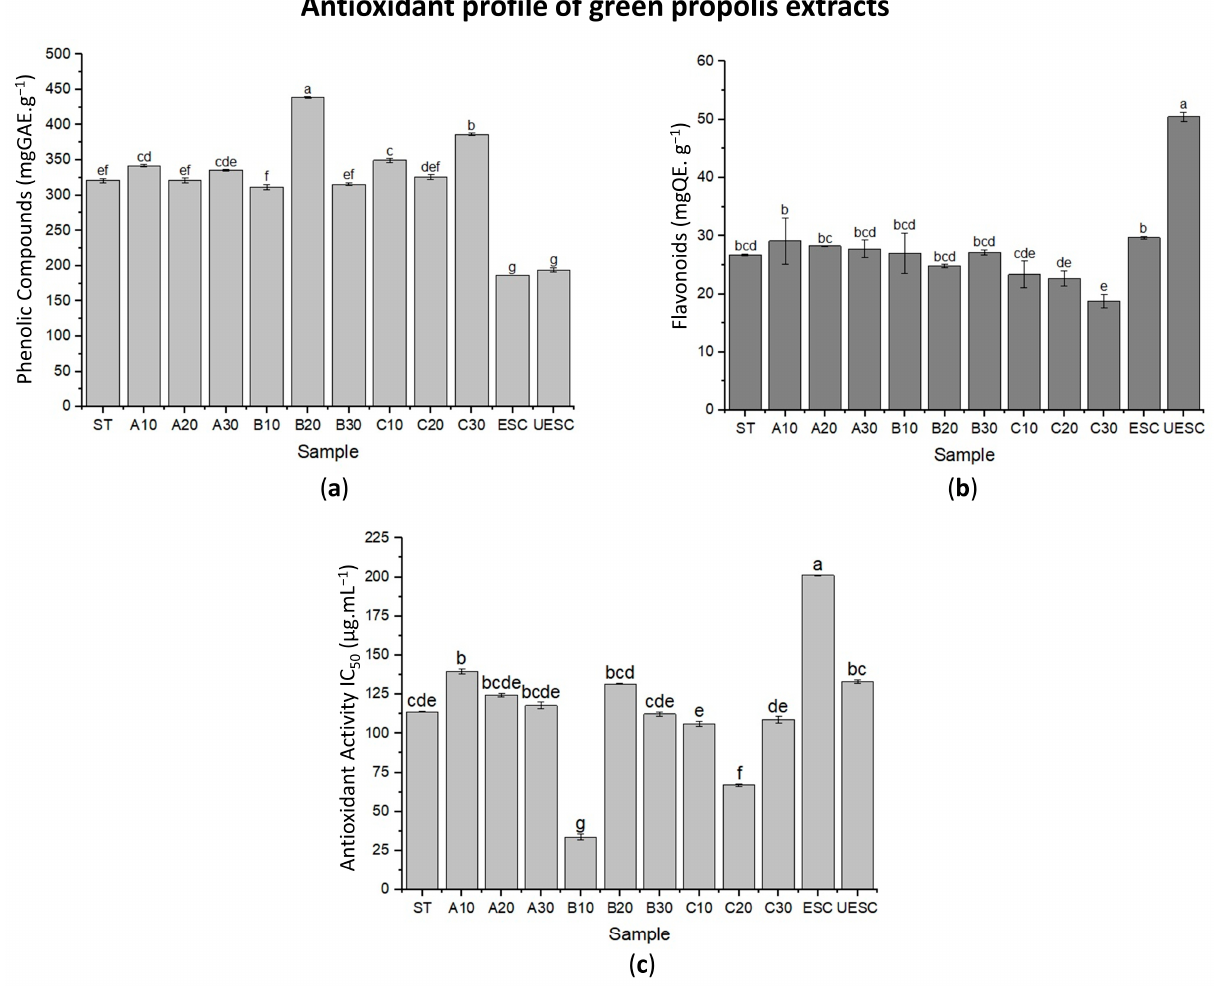
Figure 1. Antioxidant profile of green propolis extracts: ( a ) Determination of total phenolic compounds (mgGAE·g − 1 ); ( b ) flavonoids (mgQE·g − 1 ) and ( c ) antioxidant capacity to DPPH (IC 50 ) of different green propolis extracts obtained by ethanolic (LPE) and supercritical extraction (SFE). Error bars represent the standard deviation ( n = 3). Values presenting the same letter do not show significant differences ( p > 0.05) in Tukey’s test at 95% confidence.